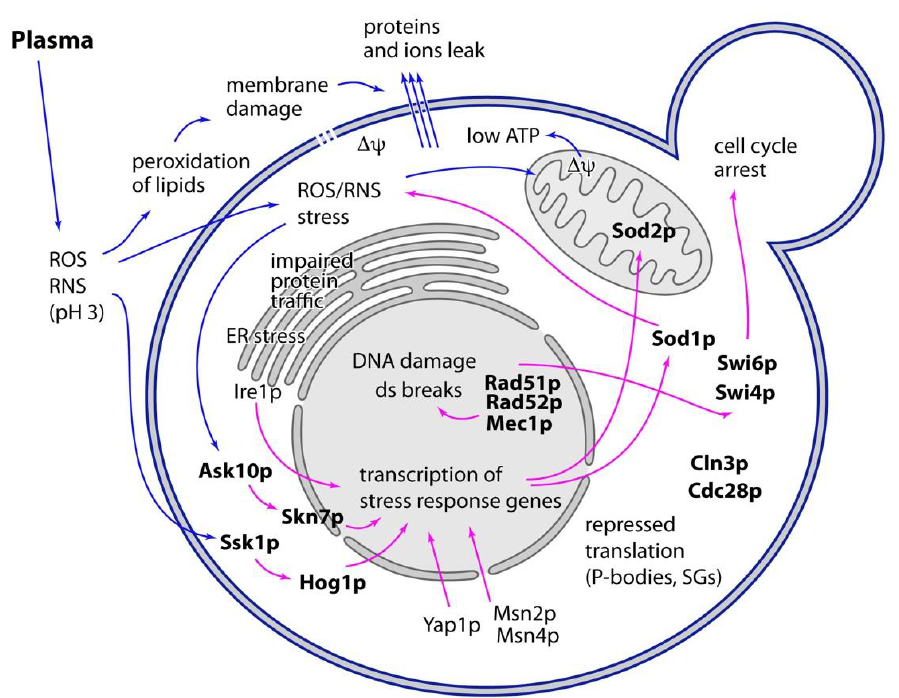
Figure 2. Summary of cold plasma effects on yeast cell. Treatment of cells with plasma induces multiple types of stress and damage (blue arrows). Cellular stress response pathways (purple arrows) act to protect cell from damage. Components of these pathways that are known to affect the cell survival (e.g., deletion of genes encoding for these components results in increased sensitivity of cells to plasma) are shown in bold.